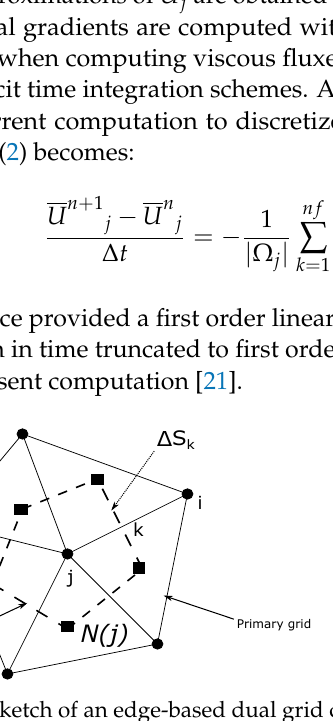
Figure 7. Sketch of an edge-based dual grid control volume